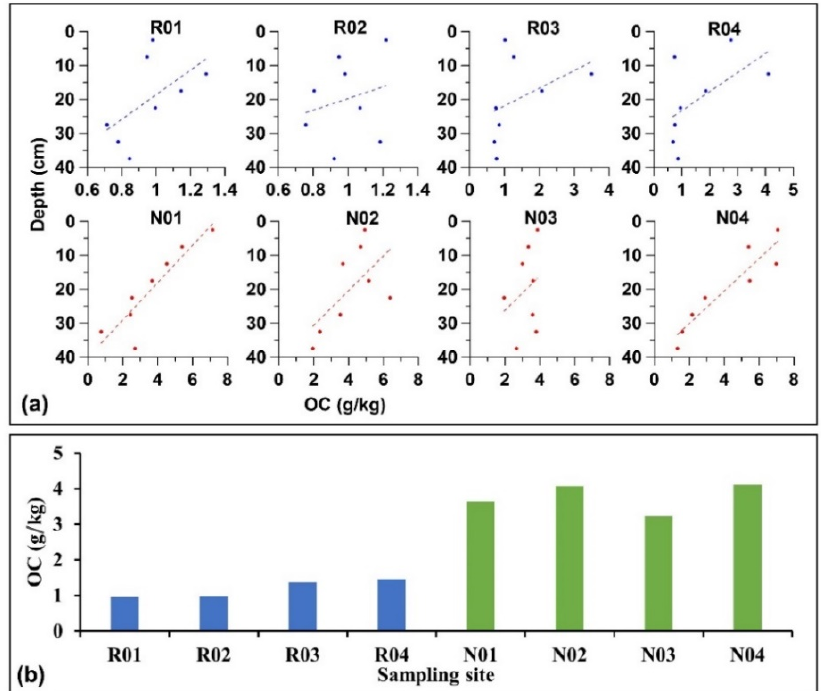
Figure 6. Change in soil organic carbon (OC) content with depth at each sampling site. ( a ) The change in soil organic carbon content with depth; ( b ) the mean soil organic carbon content at each sampling site.